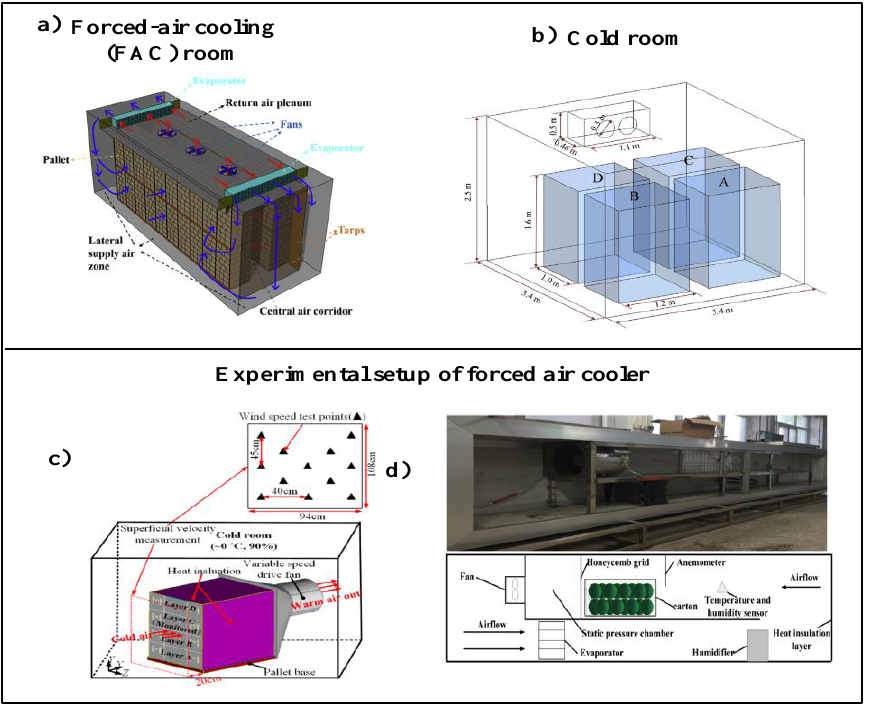
Figure 1. Different experimental setups built at different scales: ( a ) [23] and ( b ) [24] scale of a refrigerated facility, ( c ) [25] scale of a pallet, ( d ) [26] scale of one box.